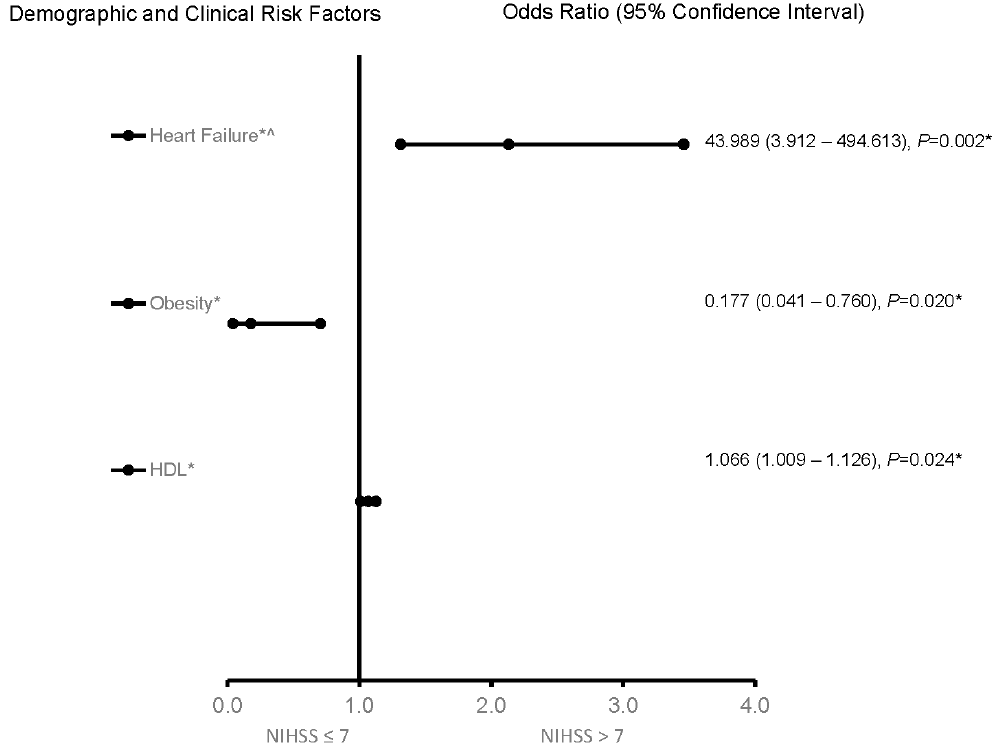
Figure 3. Factors associated with stroke severity for 65–74-year-old patients. OR > 1 denotes factors associated with having an NIHSS score > 7 or worsening neurologic functions. Hosmer–Lemeshow test: p = 0.543; Cox and Snell: R2 = 0.235. The overall classi fi ed percentage of 84.9% was applied to check the fi tness of the logistic regression model. * indicates statistical signi fi cance ( p <0.05) with a 95% con fi dence interval, ^ Indicates that data were modi fi ed by taking the 5th square root.